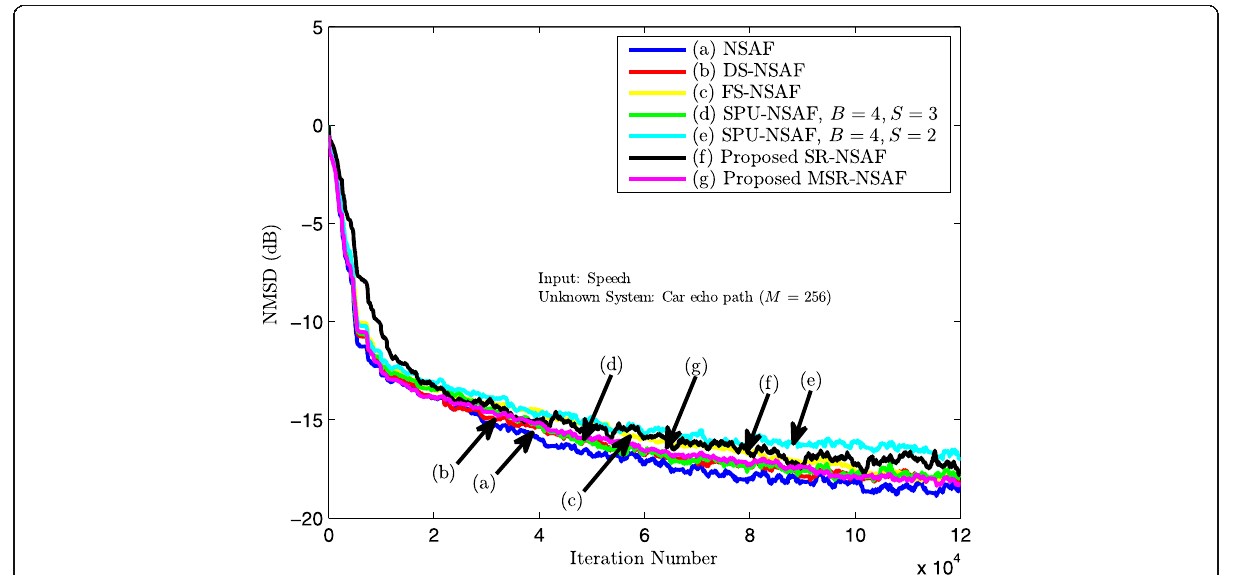
Fig. 11 NMSD learning curves of NSAF, DS-NSAF, FS-NSAF, SPU-NSAF, SR-NSAF, and MSR-NSAF with N = 4. Under-modeling scenario, speech input signal